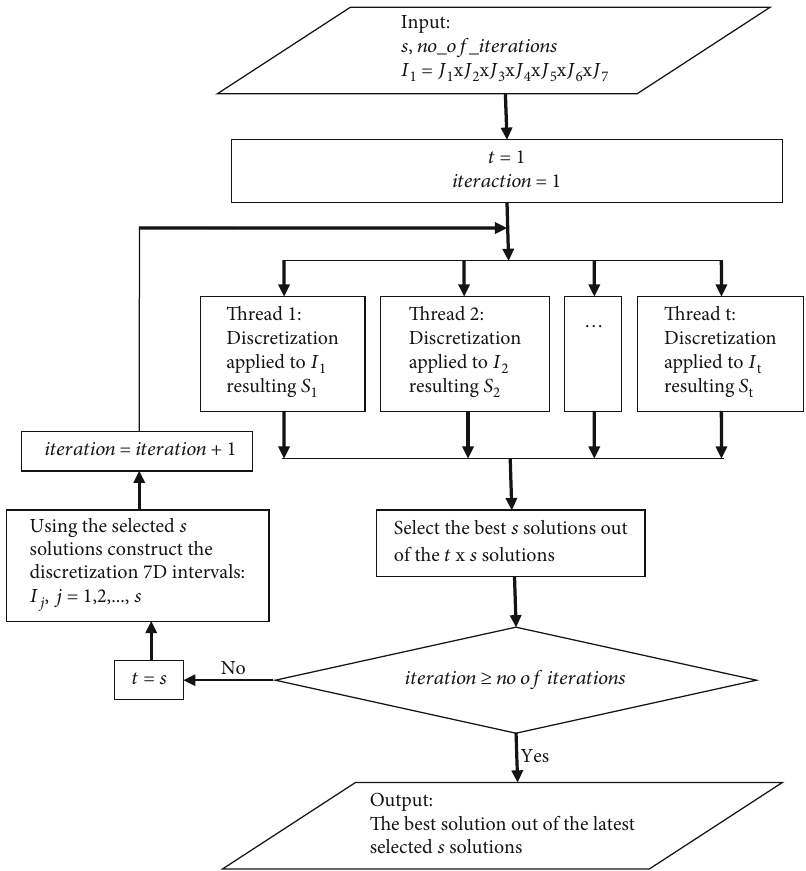
Figure 2: Flowchart of the parallel implementation of the algorithm. Table 1: The seven parameters of the RTC photovoltaic